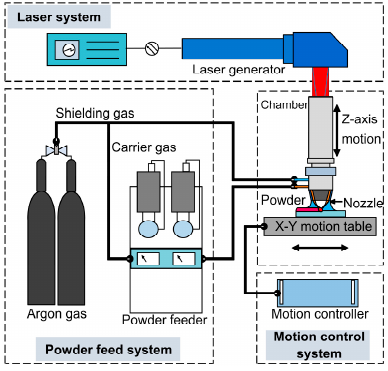
Figure 1. Illustration of the LENS TM system employed in the experiment.